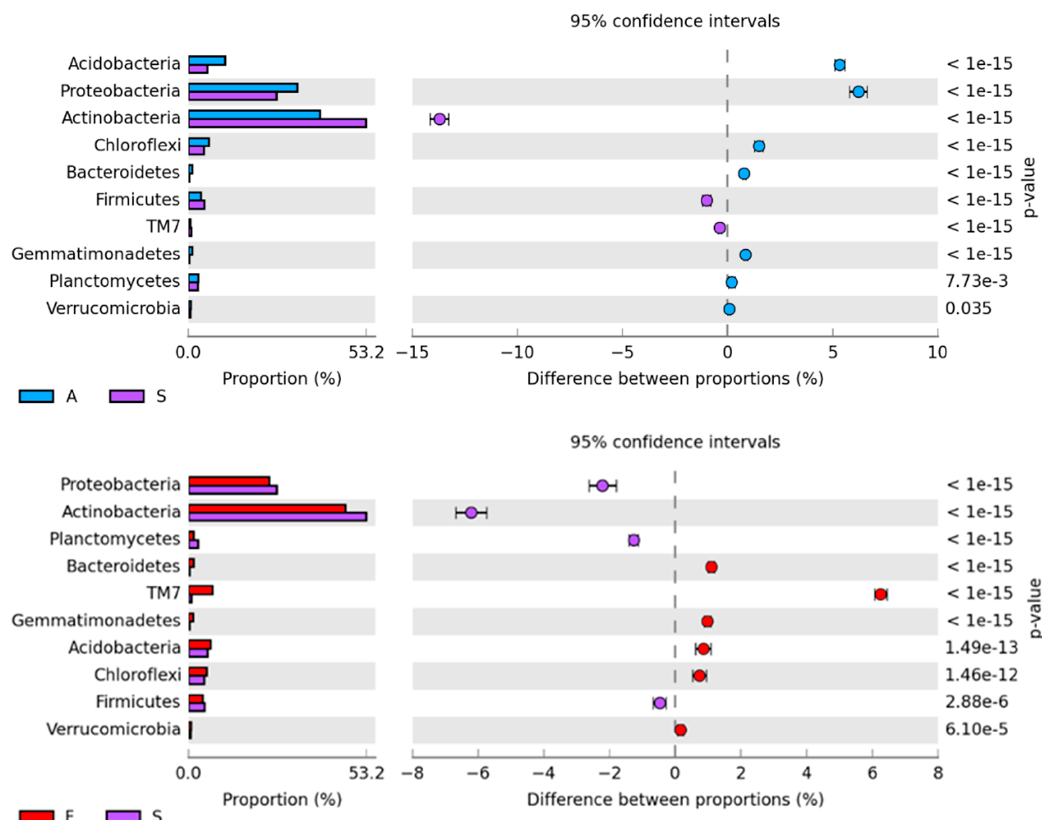
Figure 6. The relative abundance of the dominant bacterial type in soil with a difference between proportions ≥ 1%. C—uncontaminated soil; A—soil contaminated with BPA; F—soil contaminated with BPF; S—soil contaminated with BPS.